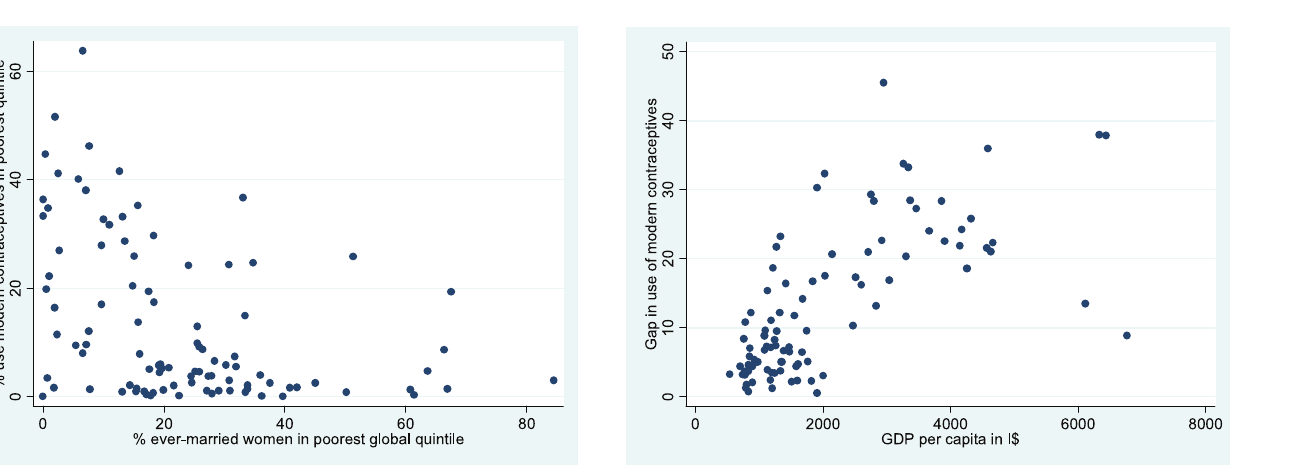
Figure 1. Modern Contraceptive-Method Use in the Poorest Global Quintile The relationship between the percentage of ever-married women and the use of modern contraceptive methods by ever-married women in the poorest global quintile is shown.